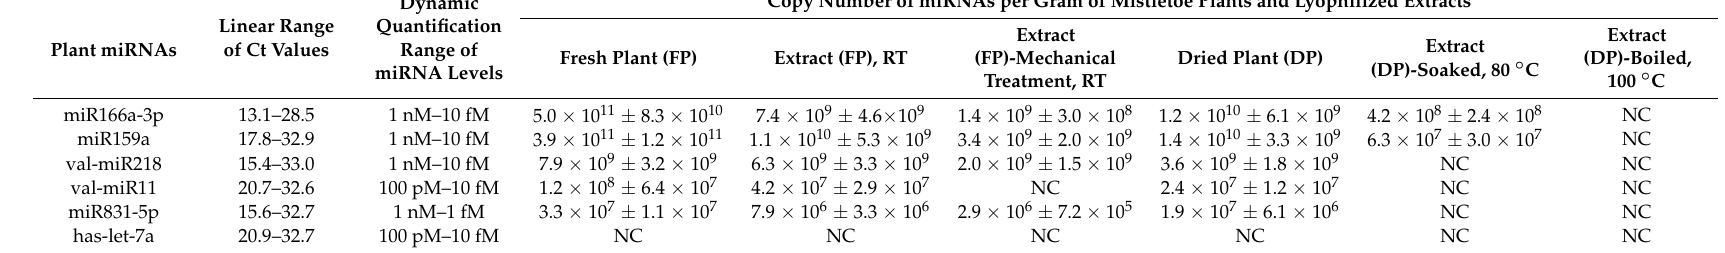
Table 2. The absolute quantification of miRNAs in mistletoe plants and lyophilized mistletoe